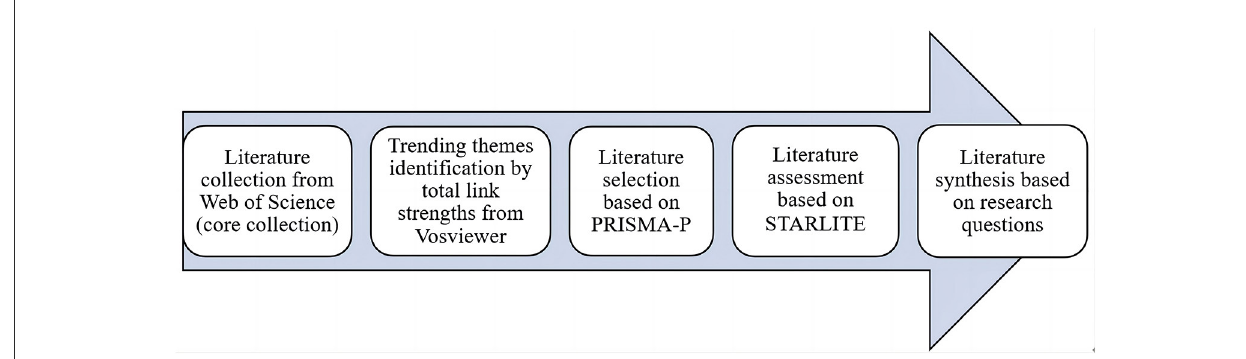
FIGURE1 Steps of literature collection and selection.